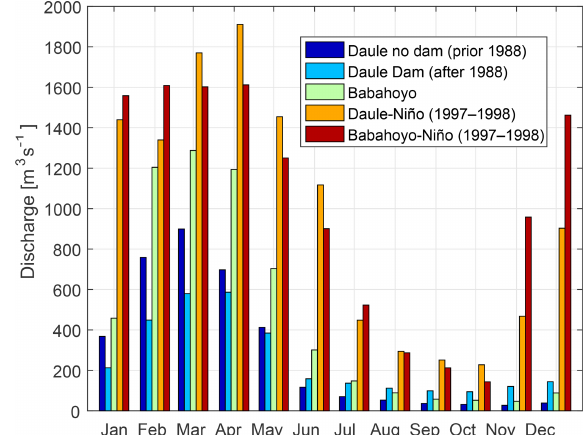
Figure 2. Monthly averaged discharge for the Babahoyo and Daule